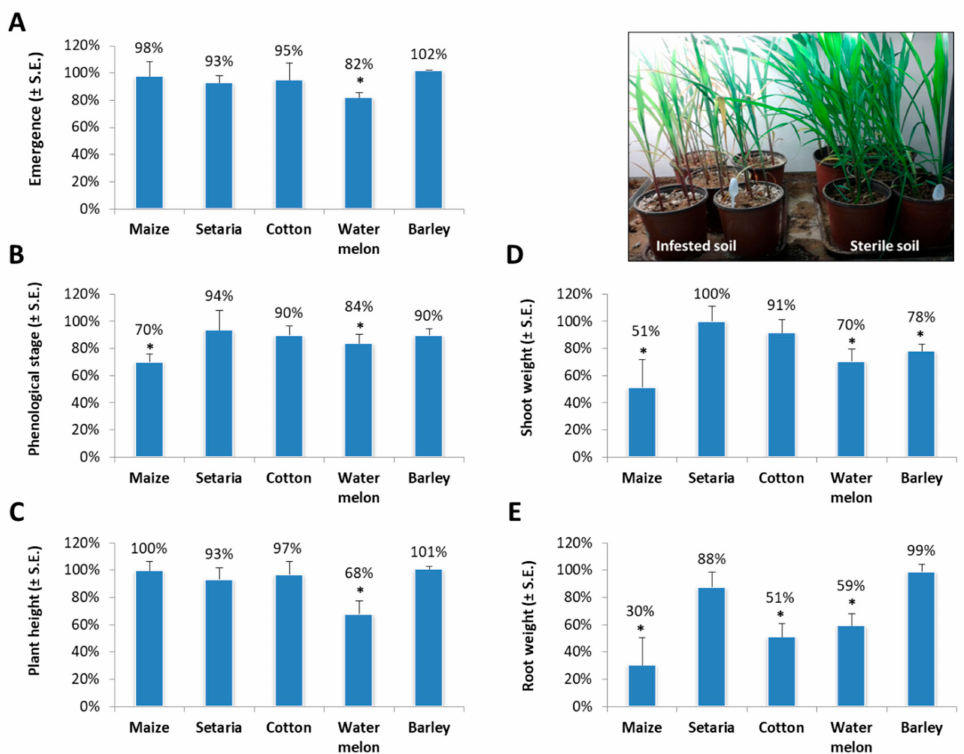
Figure 2. Sprout pathogenicity assay. Symptoms evaluation was made for the cultivar species inspected in Figure 1. Values are expressed as being di ff erent from the control (uninfected plants) in percentages. Sprout emergence ( A ), phenological stage (numbers of leaves, ( B ), plant height ( C ), aboveground parts wet weight ( D ), and root wet weight ( E ) were determined after growing the di ff erent plant species in a soil infected with M. maydis in a growth chamber for 37 days. The results are the average of two separate experiments; each included five independent replications (pots). Vertical upper bars represent the standard error. Significance from the control (untreated plants) is indicated as * = p < 0.05. Insert—photo of the sweet, sensitive maize Prelude cv. at the end of the